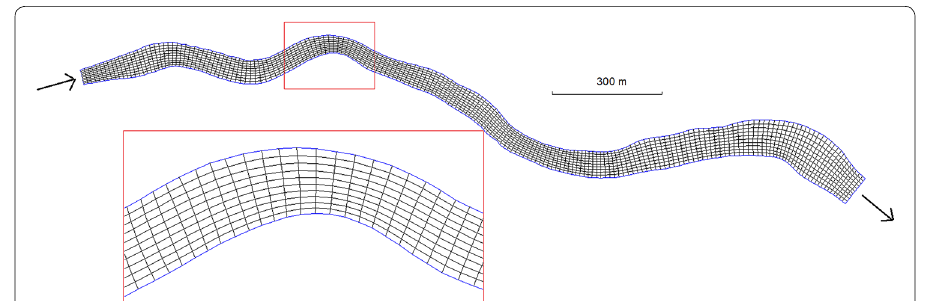
Fig. 1 Plan view of the 2D depth-averaged grid for the Bodendorf reservoir with 10 cells in the lateral direction and 195 cells in the longitudinal direction. The arrows indicate the inflow and outflow regions. The computational grid used in the current study used 80 and 1560 cells in lateral and longitudinal direction, respectively